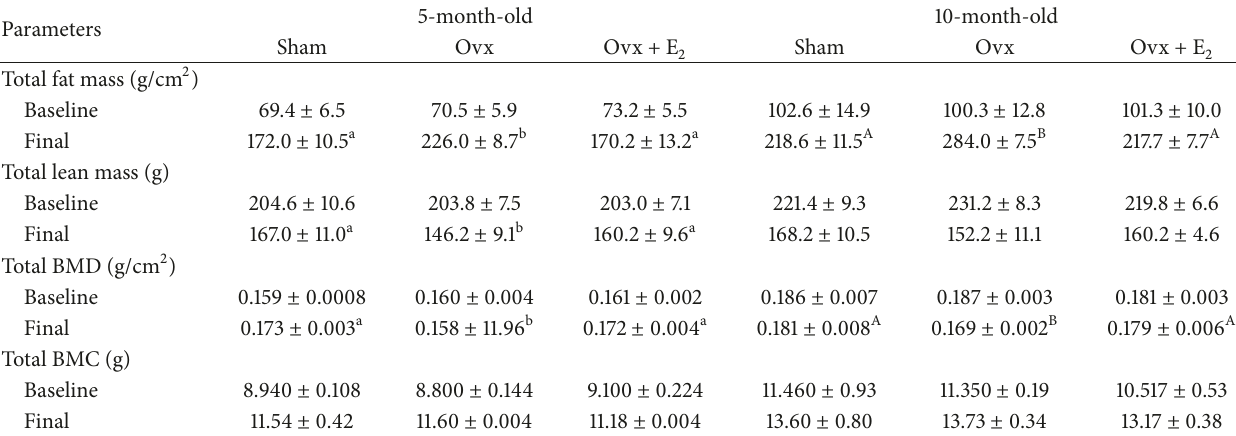
Table 2: The effects of ovariectomy (ovx) and 17 𝛽 -estradiol (ovx + E 2 ) on body composition in rats with initial ages of five and ten months. Ovariectomy induced a significant increase in total fat mass and a decrease in bone mineral density in both age groups and a decrease in lean mass in the older group. E 2 administration prevented ovx-induced alterations in body